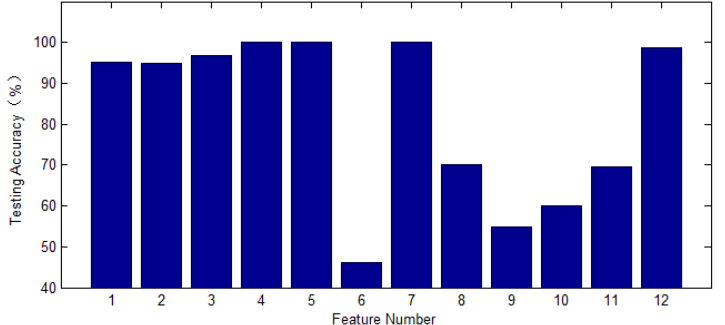
Figure 9. Diagnostic accuracy of fault isolation for the rolling bearing. 1: Ma ; 2: Mi ; 3: P k ; 4: A v ; 5: st ;